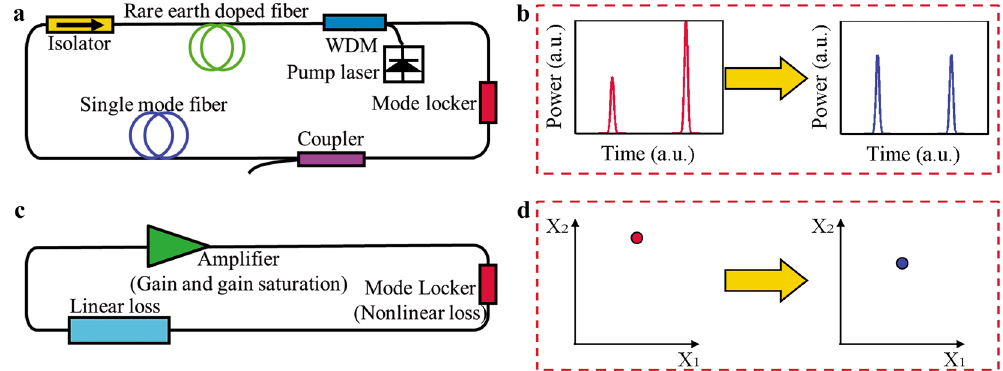
Figure 1. Schematic diagram of the mode-locked laser.